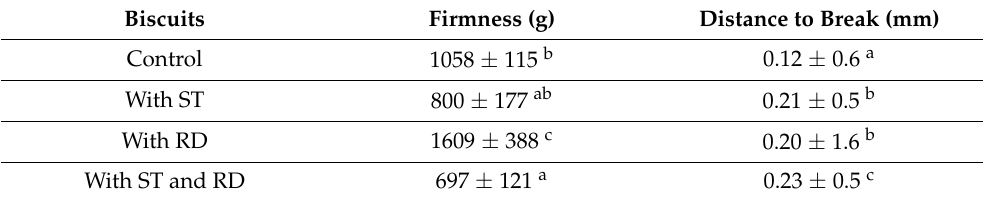
Table 4. Textural properties of control and substituted